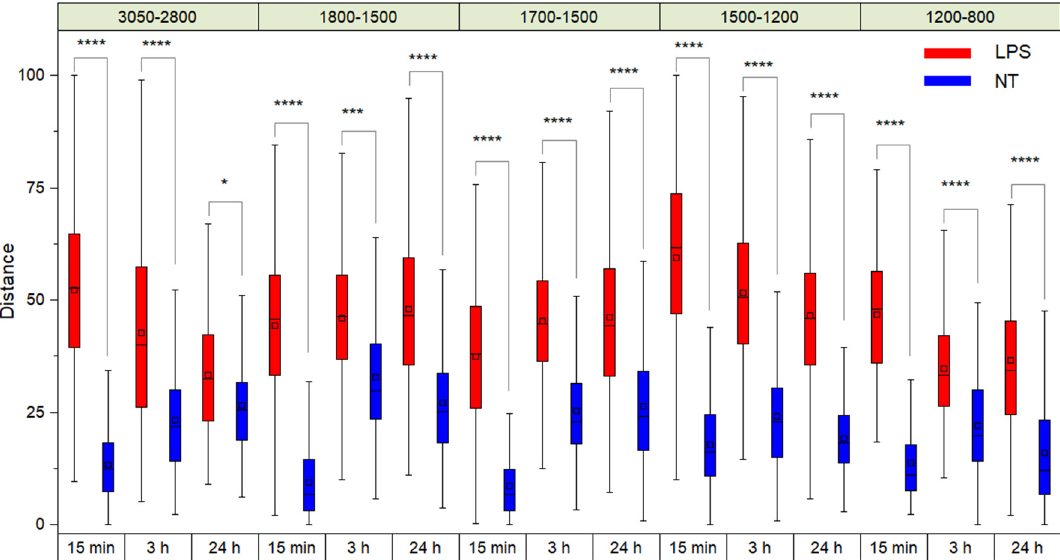
Figure 1. Euclidean distance values of the PLS-DA projections of TDM cells treated with LPS and non-treated cells (NT) for time zero analyses (0 h). The black horizontal line within the box is the median, the square within the box is the mean, the box ends show the first (Q1) and third (Q3) quartiles, the lower whisker is computed as the maximum value between the absolute minimum and Q1 − 1.5 × IQR, and the upper whisker is the minimum between the absolute maximum and Q3 + 1.5 × IQR. Here, IQR is the interquartile range computed as Q3–Q1. Stars (*, ***, ****) indicate the statistical significance evaluated by a two-ways repeated-measurement ANOVA analysis.